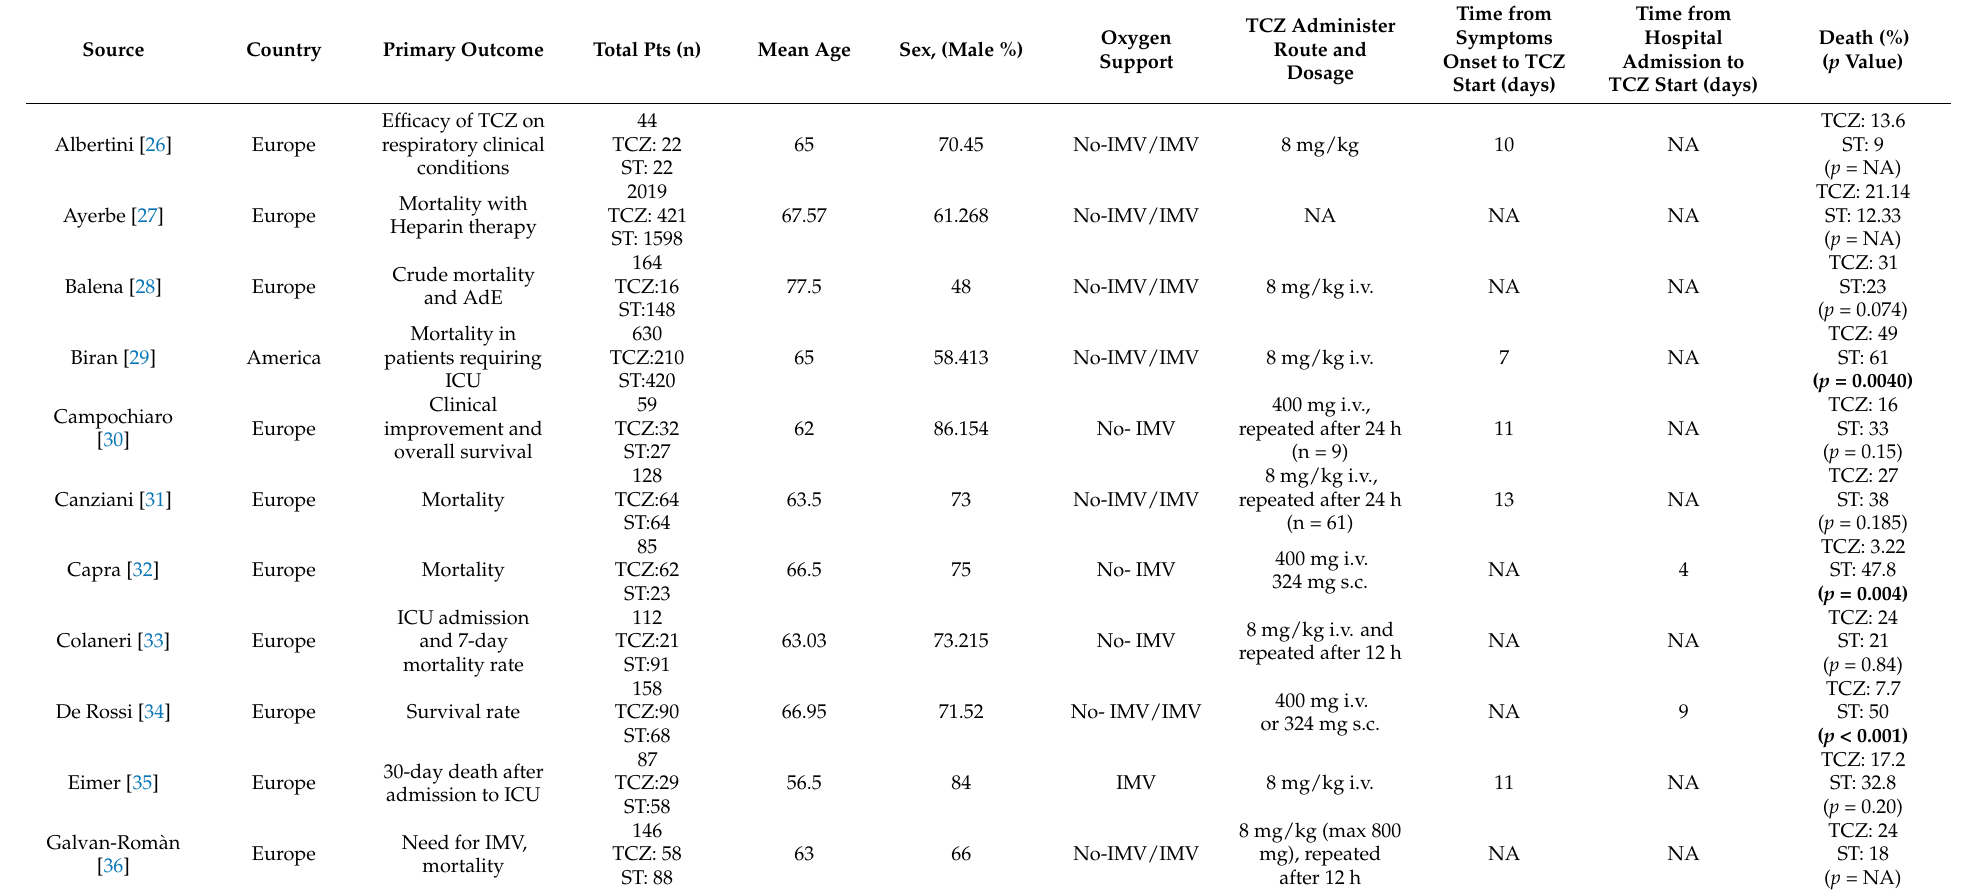
Table 2. Characteristics of the observational studies introduced in the